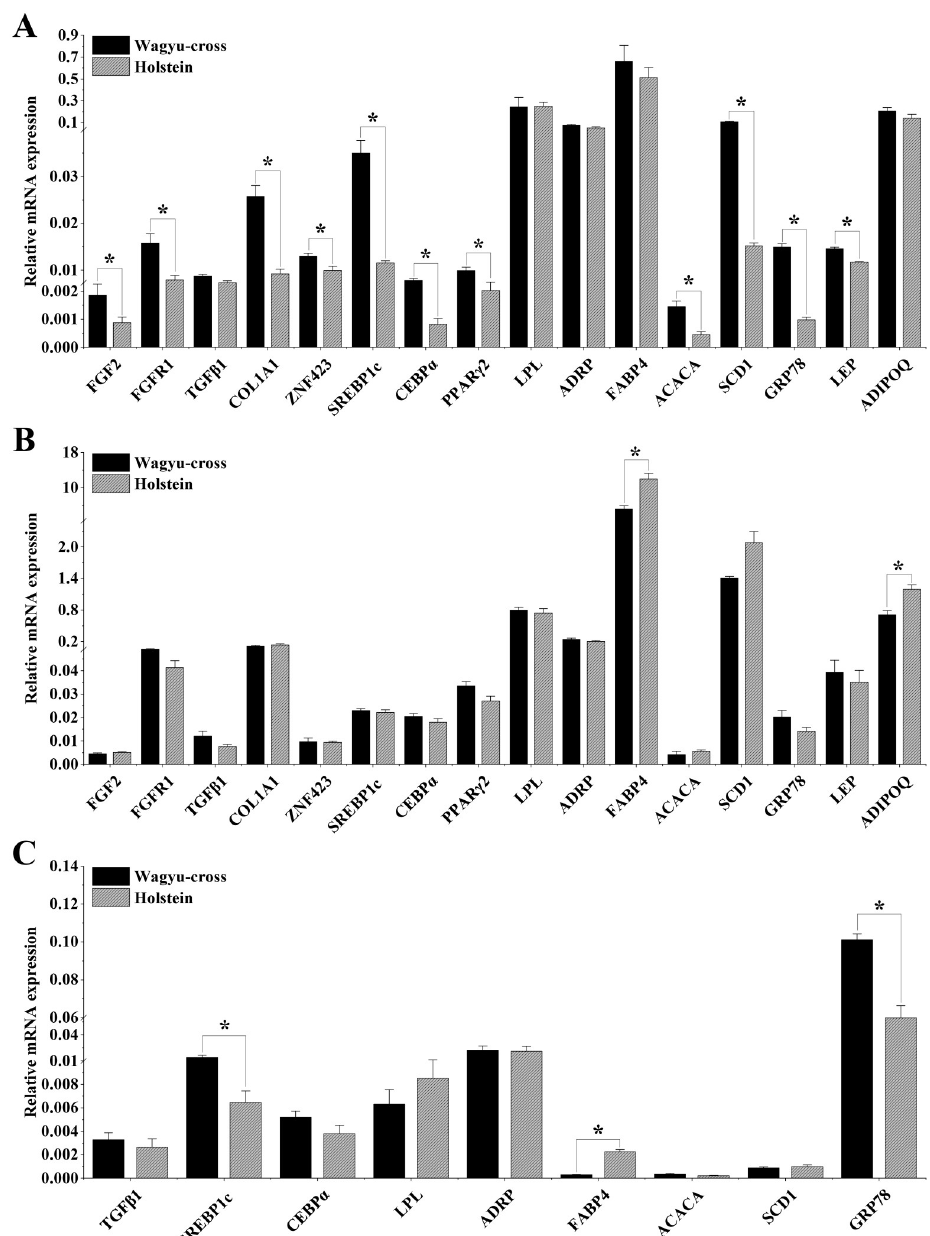
Fig 2. Relative gene expression in the LM (A), SCF (B) and liver (C) from Wagyu-cross and Holstein steers. The expression levels were calculated using the 2 - Δ Ct method and were normalized to RPLP0. Bar values represent the mean ± SEM, and asterisks indicate p < 0.05 between the two